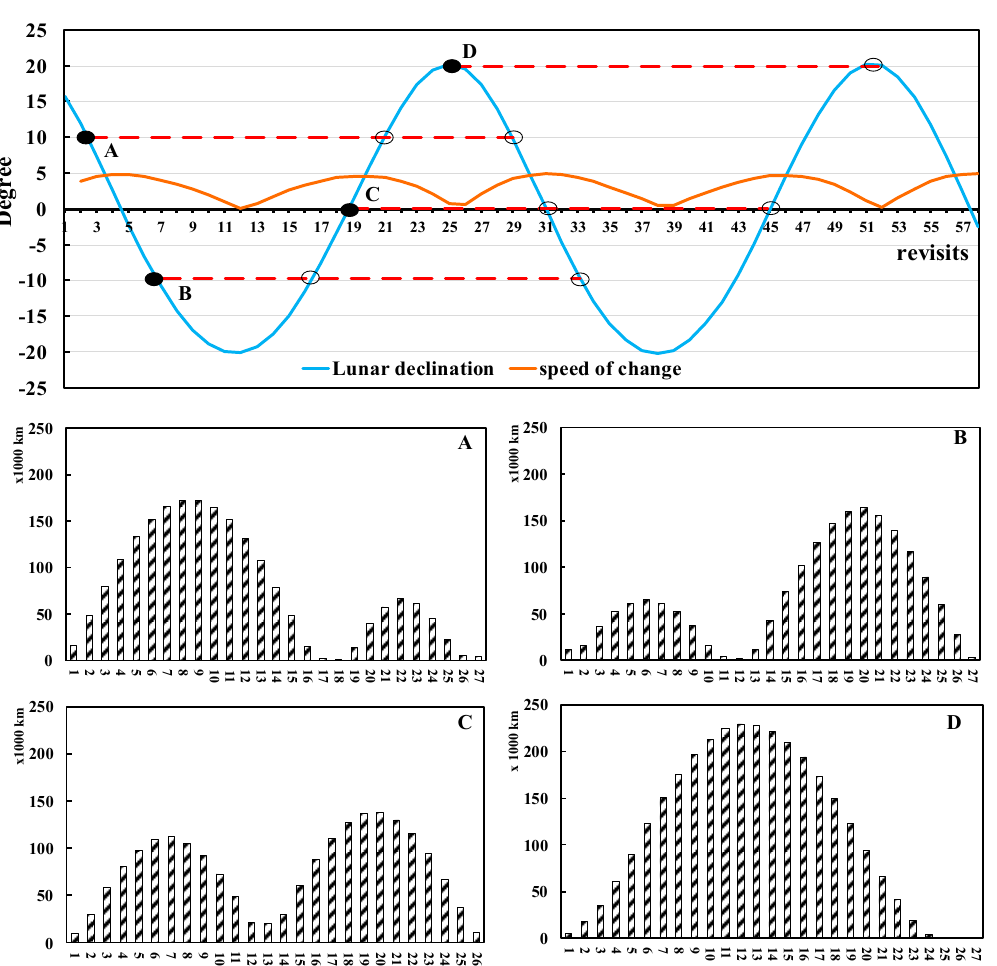
Figure 10. Lunar declination in February and March 2018, as well as the four cases for the change of spatial baseline. The horizontal axis represents the revisit times. The vertical axis of the upper figure represents the lunar declination. The blue line and the orange line represent the trend of declination and its own change speed, respectively. ( A – D ) represent the change trend of spatial baseline in different revisits when the time point of the master image was located at the lunar declination shown in the upper figure.